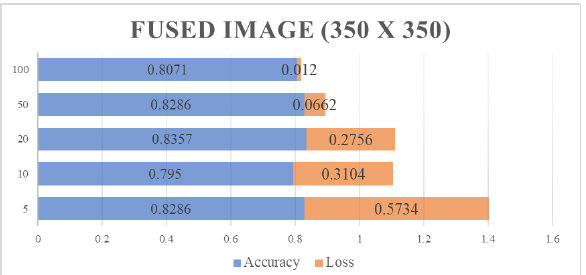
Figure 21 . Graph of Fused Image (350 X 350).